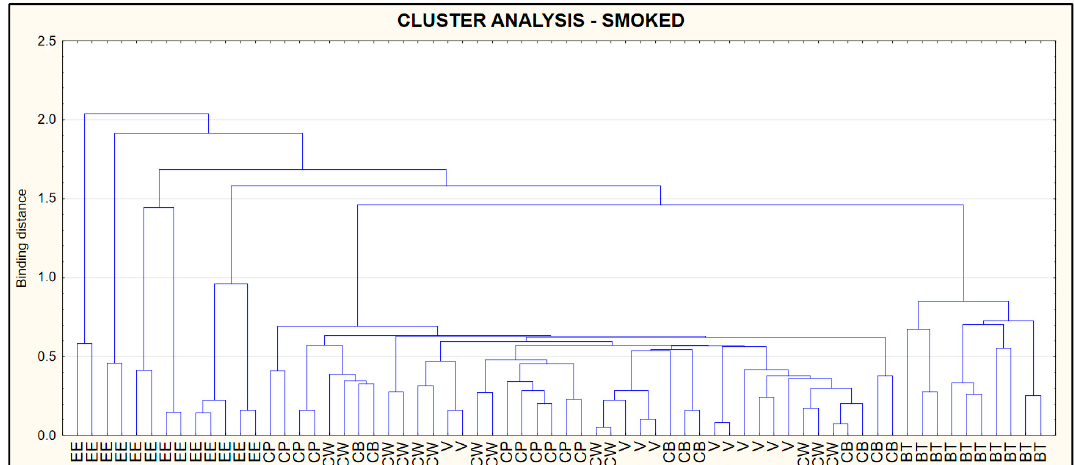
Figure 6. Dendrogram of similarity in protein, fat, salt, collagen and water in raw fish.